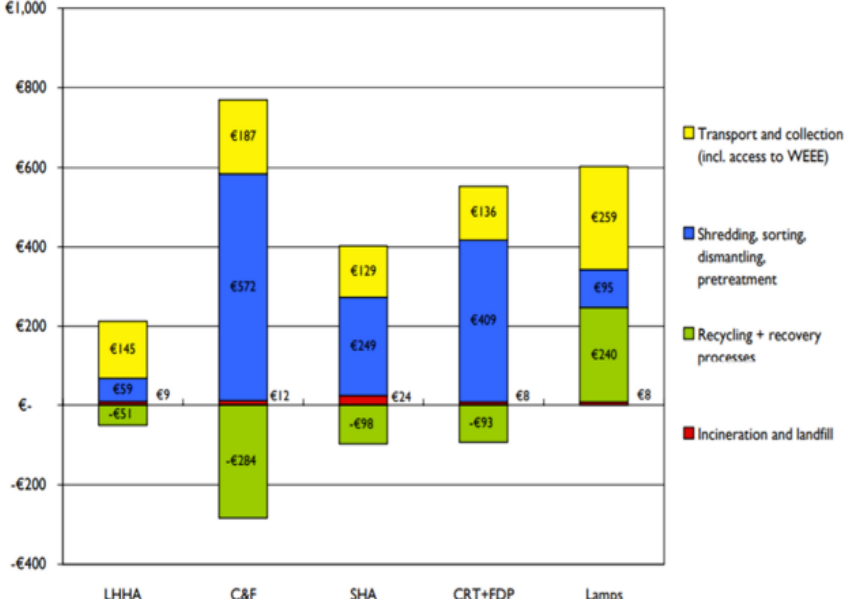
Figure 1. Technical costs for the five main categories in RL per ton in 2007 [37].